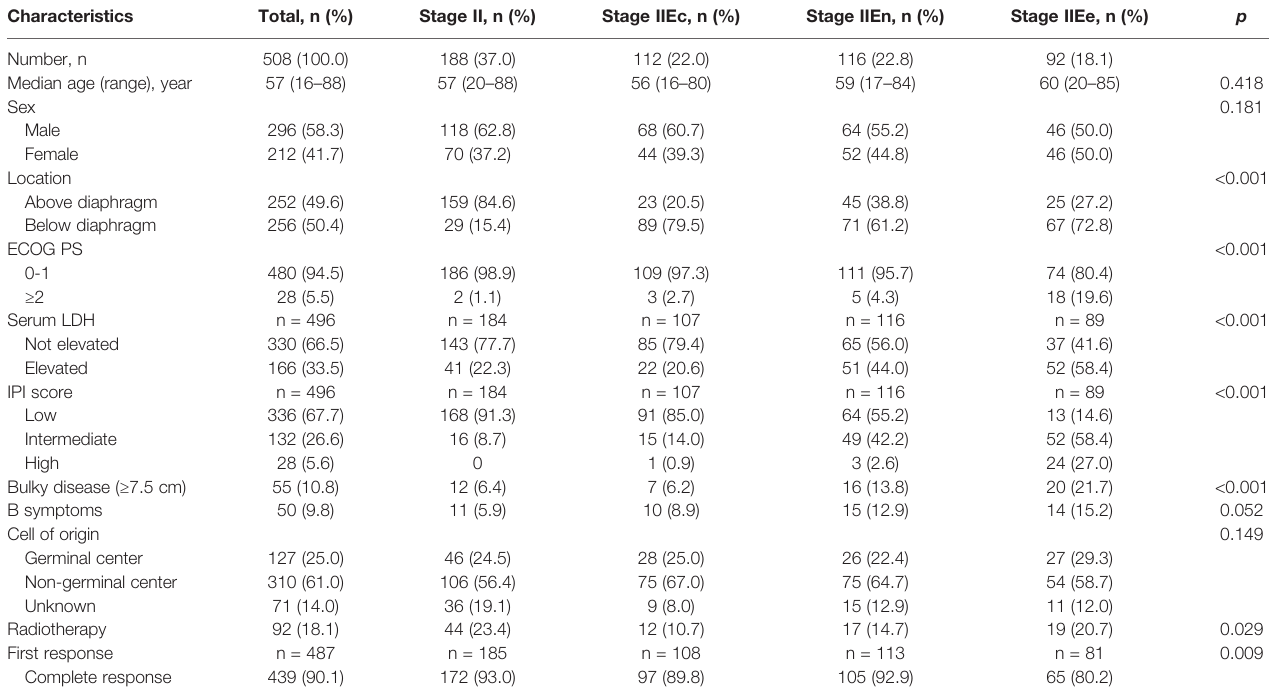
TABLE 1 | Baseline characteristics.